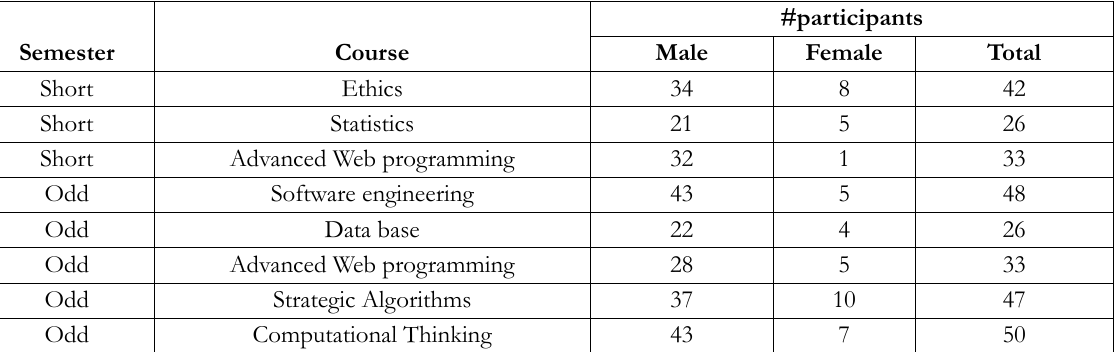
Table 1. The participants of the study